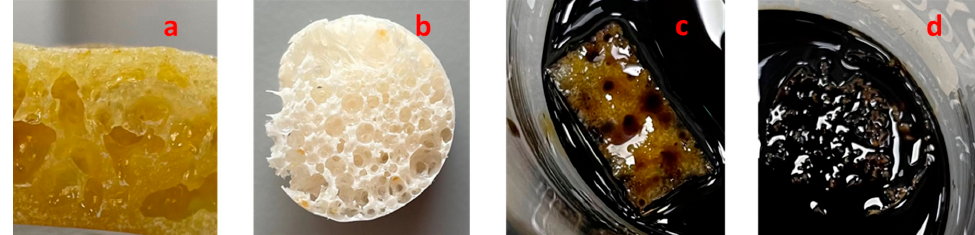
Figure 6. Represents the oil absorption studies in the biobased PU ( a ) unmodified PU, ( b ) PU-C18-DE, after in contact with crude oil for 20 min, ( c ) unmodified PU and ( d ) PU-C18-DE.